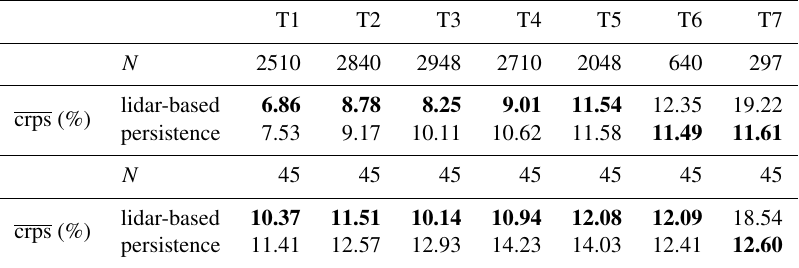
Table 3. Number of valid forecasts N and average crps for turbines T1–T7 for the probabilistic lidar-based forecast and persistence during unstable stratification for all available forecasts and all simultaneously available ones. The crps is given in percent of the turbines’ nominal power with the lowest values in